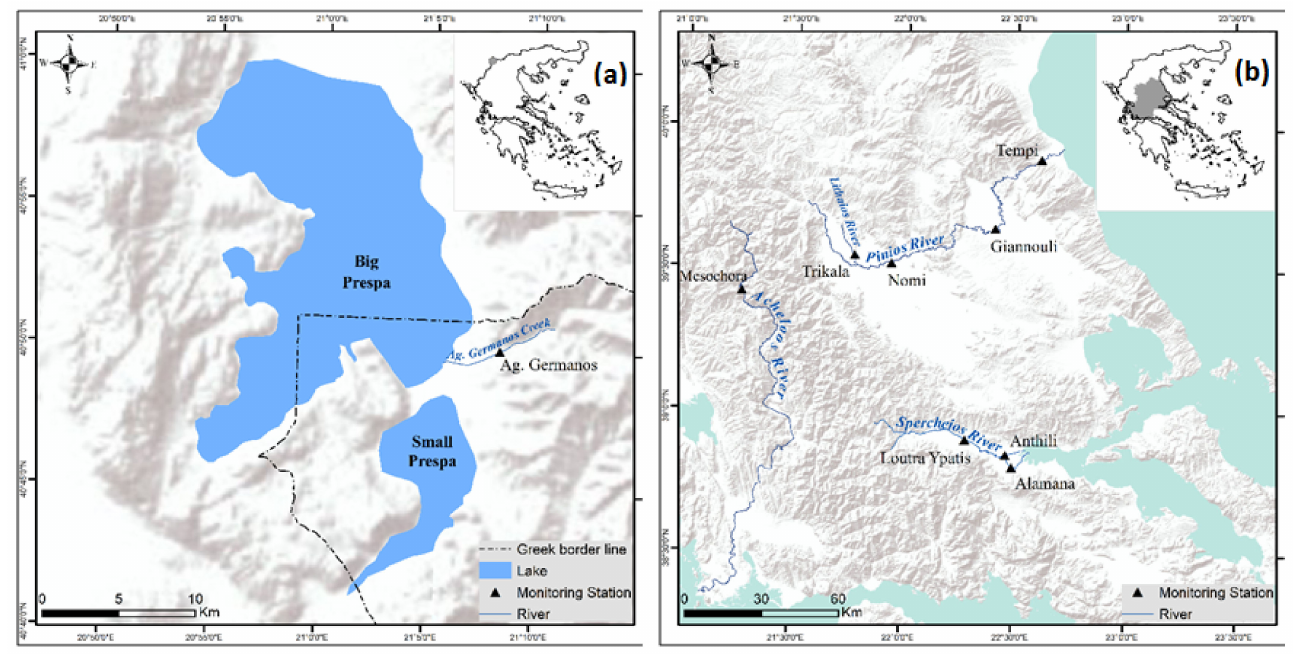
Figure 1. A typical installation of an Hellenic Centre for Marine Research (HCMR) automatic station for water monitoring: the solar panel on the pier column (left) and the instrument with the sensors in the pier’s bottom (right).